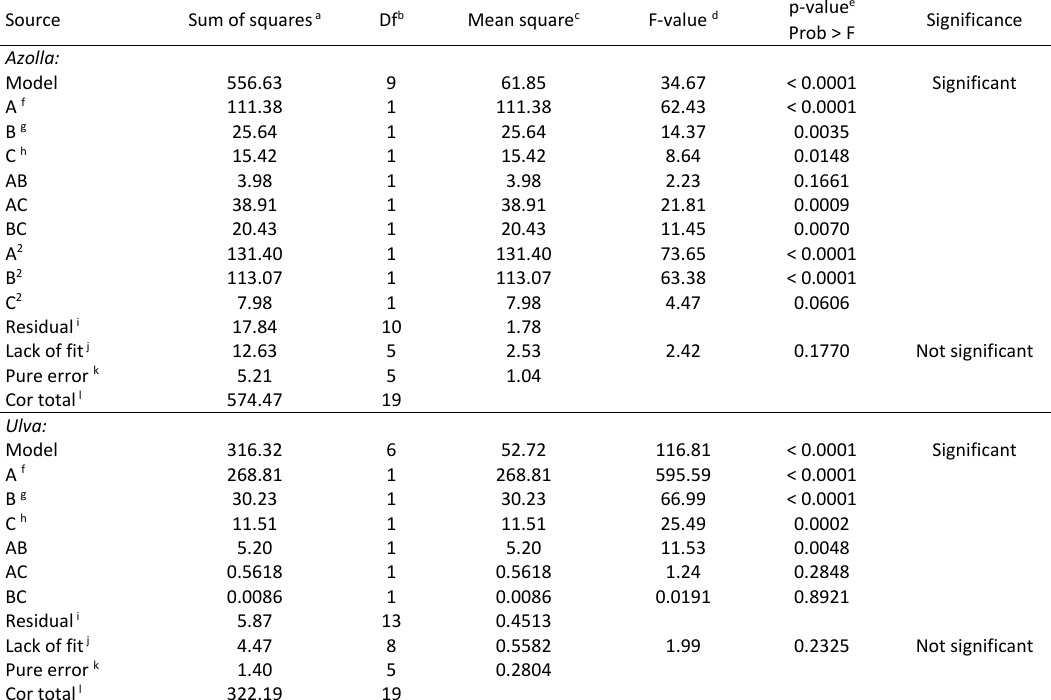
Table 4: Analysis of variance (ANOVA) for the bio-oils derived from Azolla and Ulva Source Sum of squares a Df b